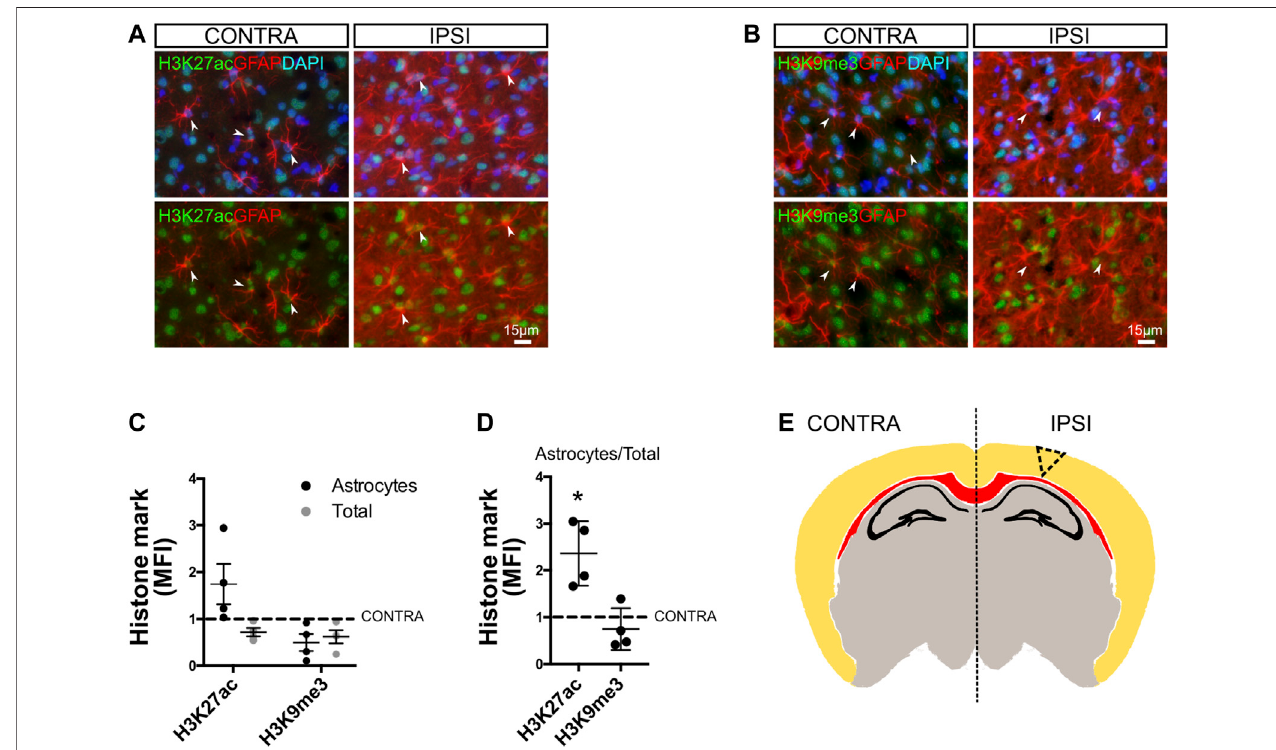
FIGURE6| Chromatinremodelinginreactiveastrocytesaftercorticalischemicinjury invivo . (A) Brainsectionsfromanimalssubjectedtocorticaldevascularization were processed for immuno fl uorescence staining. To address changes in the global levels of H3K27ac in astrocytes in response to damage, we performed double immuno fl uorescencestainingforGFAPandH3K27ac.Imagesshowrepresentative fi eldsofthecontralateral(CONTRA)hemisphereandtheipsilateral(IPSI)hemisphere withandwithoutnuclearDAPIcounterstaining.Thearrowheadsindicaterepresentativeastrocyteswithvisiblenuclei.Here,GFAPintensitywasenhancedusingFIJI software to visualize cells, and intensity is not representative of the reactivity state. (B) Similar to A, we performed double immuno fl uorescence staining for GFAP and H3K9me3. (C) Graphshowingthemean fl uorescenceintensity(MFI)forH3K27ac andH3K9me3 inthenucleiofGFAP-positive cells(black dots (cid:2) astrocytes)or inother cell types nuclei (gray dots (cid:2) total) after normalizing to the control (Ctrl (cid:2) 1). (D) Graph showing the mean fl uorescence intensity (MFI) for H3K27ac and H3K9me3 in the nuclei of GFAP-positive cells relative to the total nuclei and after normalizing to the control (Ctrl (cid:2) 1). Average from the hemisphere of one animal was compared to the respectivecontralateralhemisphere(CONTRA)usingone-samplet-testwiththestatisticalsigni fi cancerepresentedas* p < 0.05,n (cid:2) 4. (E) Schematicrepresentationofa coronalsectionfromamurinebrainindicatingthesiteofthecorticallesion(triangledottedlines).Thecorpuscallosumisshowninredandthehippocampalpyramidalcell layer and dentate gyrus are shown in